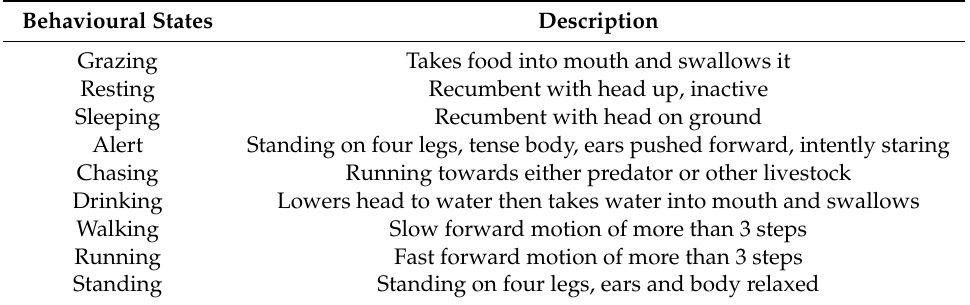
Table 1. Behavioural repertoire of alpacas: behavioural states (used to analyse video footage of alpaca field behaviour; when an alpaca was not in camera view they were recorded as ‘out of